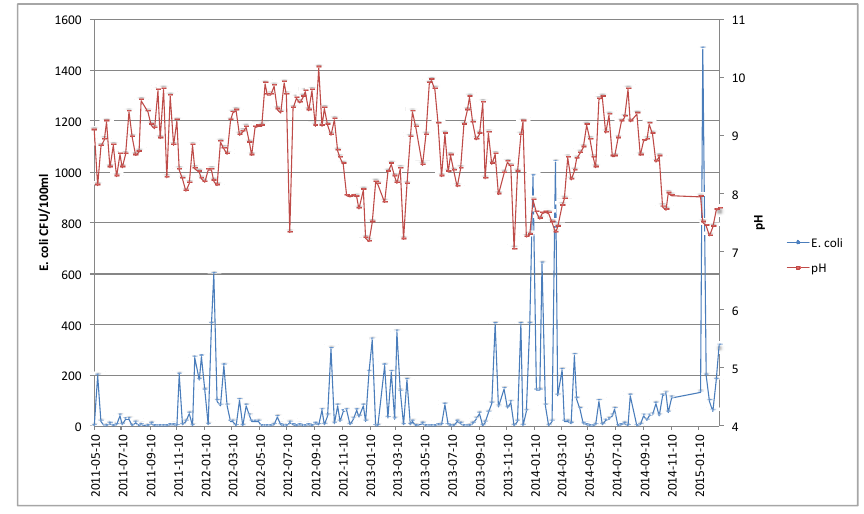
Figure 6. The relationship between E. coli population and pH in the effluent of Pond 1. Table 2. Spearman rank correlation coefficients between E. coli population and pH, DO and temperature. E. coli pH ´ 0.54 DO ´ 0.11 Temperature ´